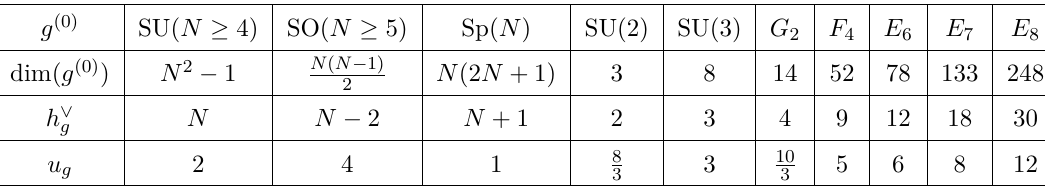
, and u coefficient (defined in (4.7)) for all g g